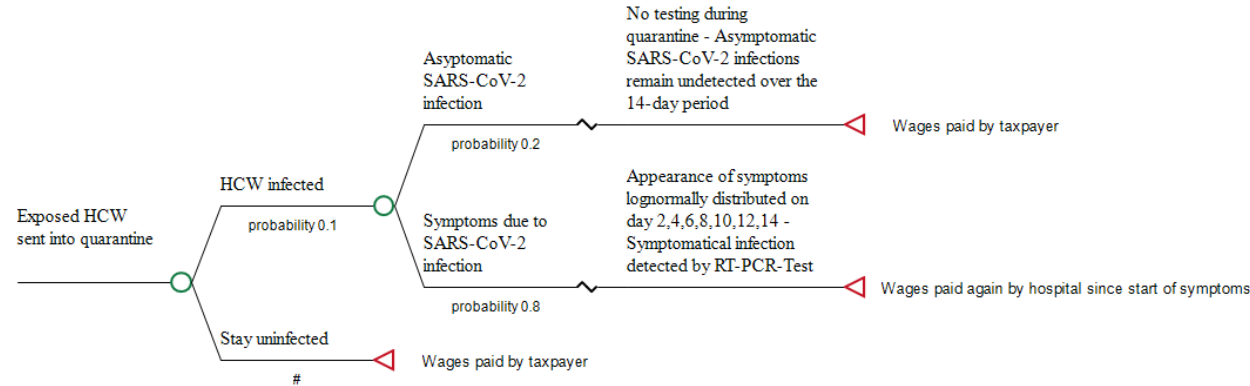
Figure 1. Pathway of sending exposed HCW into quarantine (Scenario 1). #: Complementary probability (all probabilities of chance node’s branches to sum to 1.0).